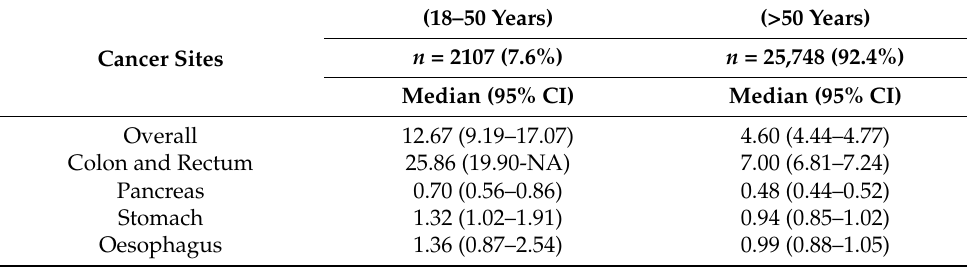
Table 3. Median survival times for primary sites of cancer between two age groups ( n =